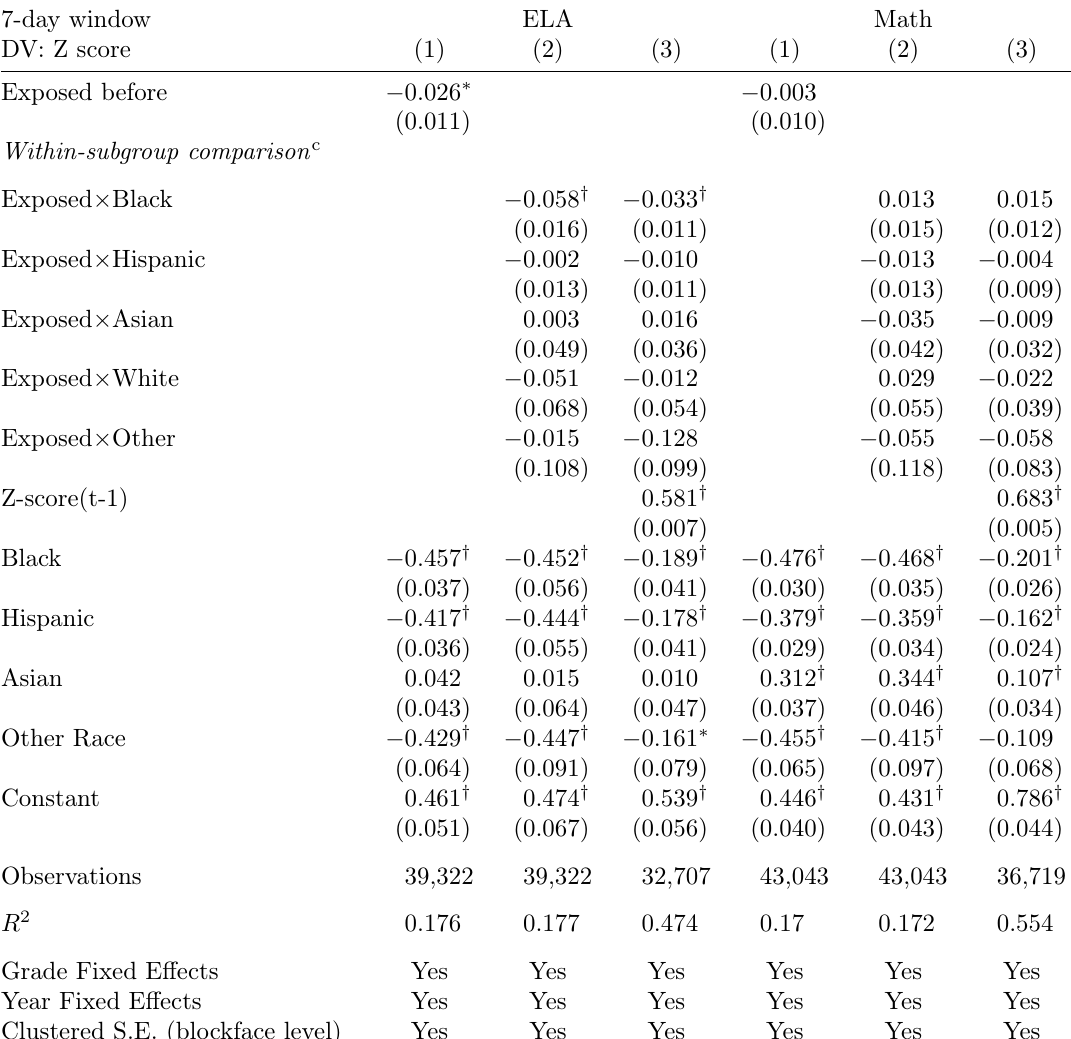
Table 3: Covariate Models (School Years 2004/2005 to 2009/2010): Impact of Exposure to Violent Crime a and in a High-Poverty Sample